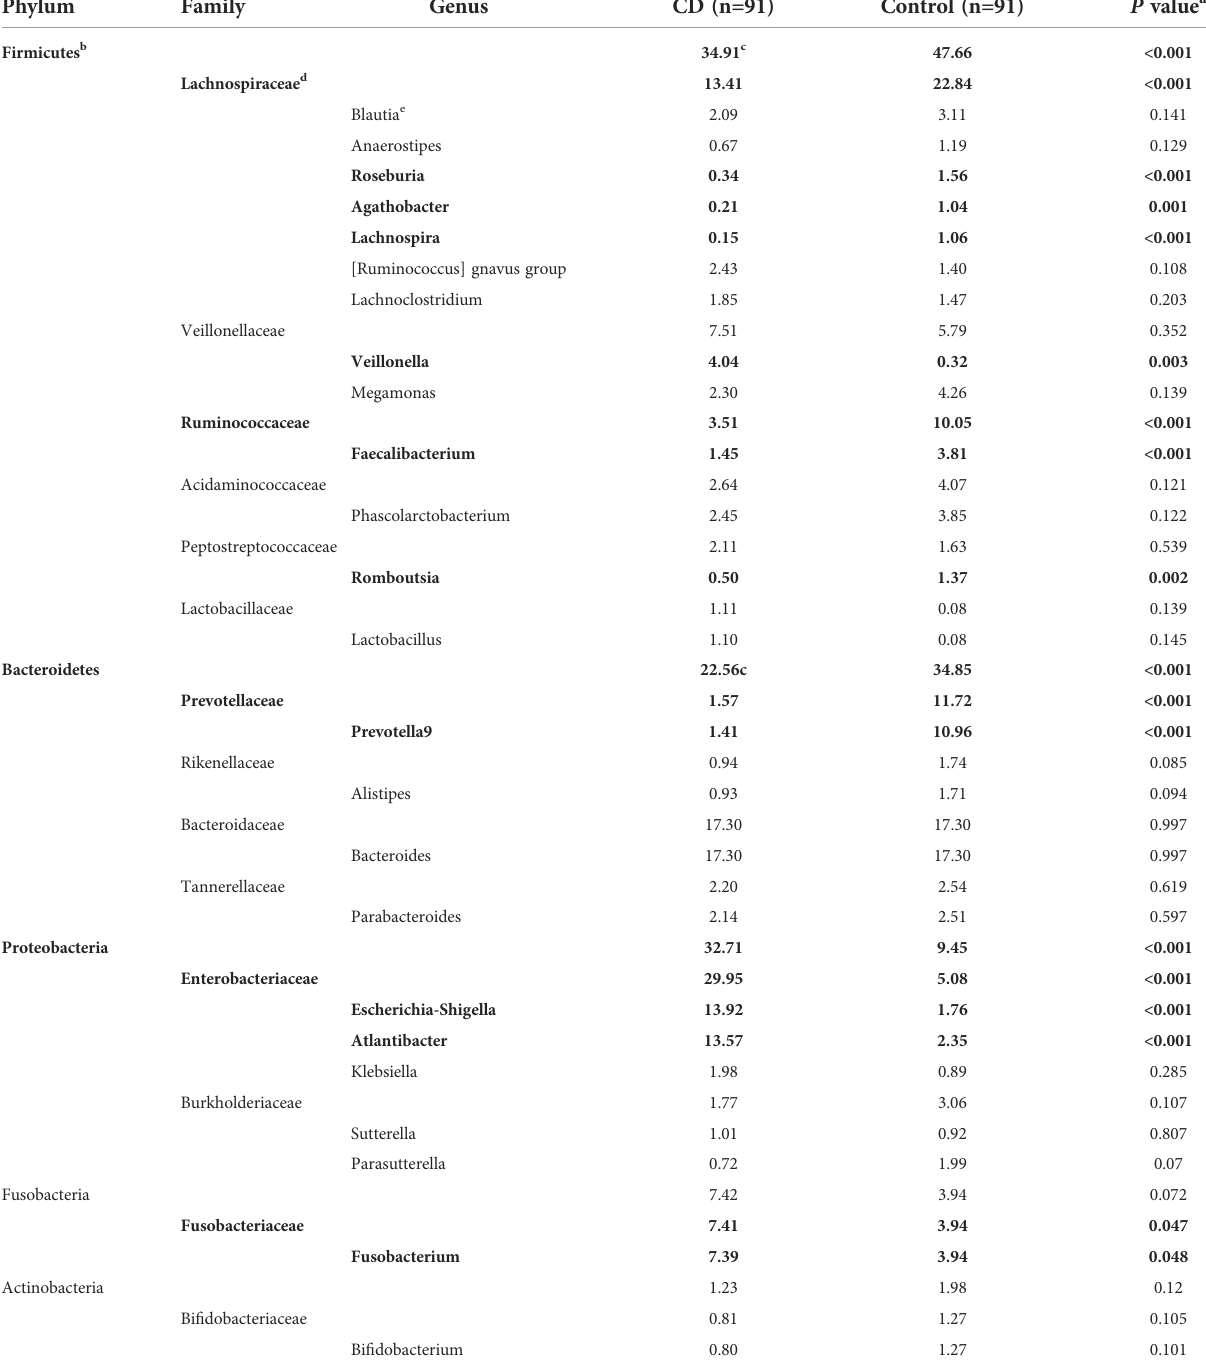
TABLE 2 Abundant taxa in the gut microbiota of IBD patients and their healthy relatives. Phylum